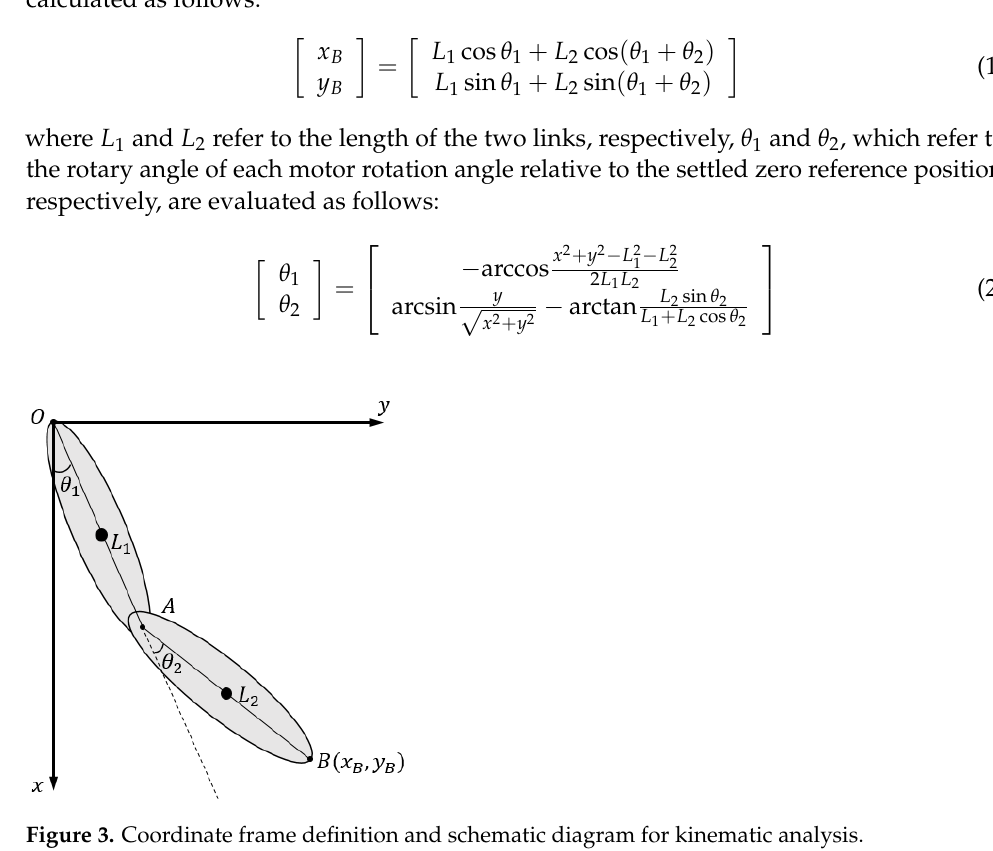
Figure 3. Coordinate frame definition and schematic diagram for kinematic analysis.